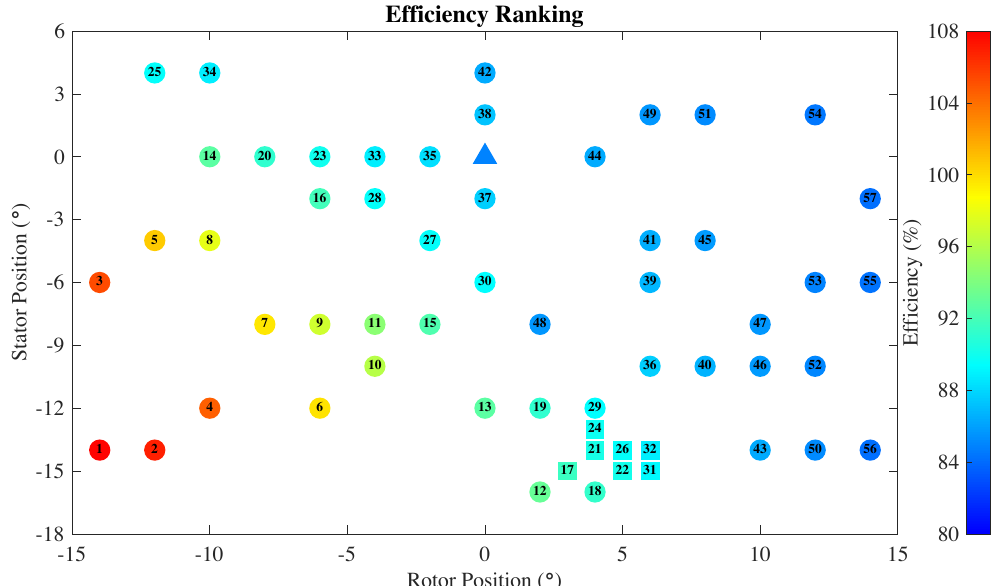
Figure 6. Scatter plot of the cases ranked by the shaft torque value with rank 1 being the highest. Cases in the initial data set are denoted by circles while the remaining cases are denoted by squares. The color fill of the circles and squares corresponds to the value of the torque. The baseline design is denoted using a triangle with the torque value of τ ref = 151.2 N · m.